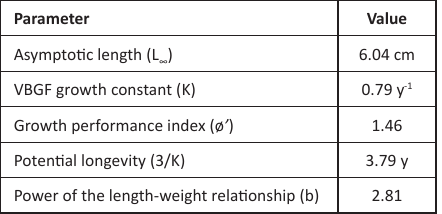
Table 2. Growth related parameters of Acanthocobitis mooreh